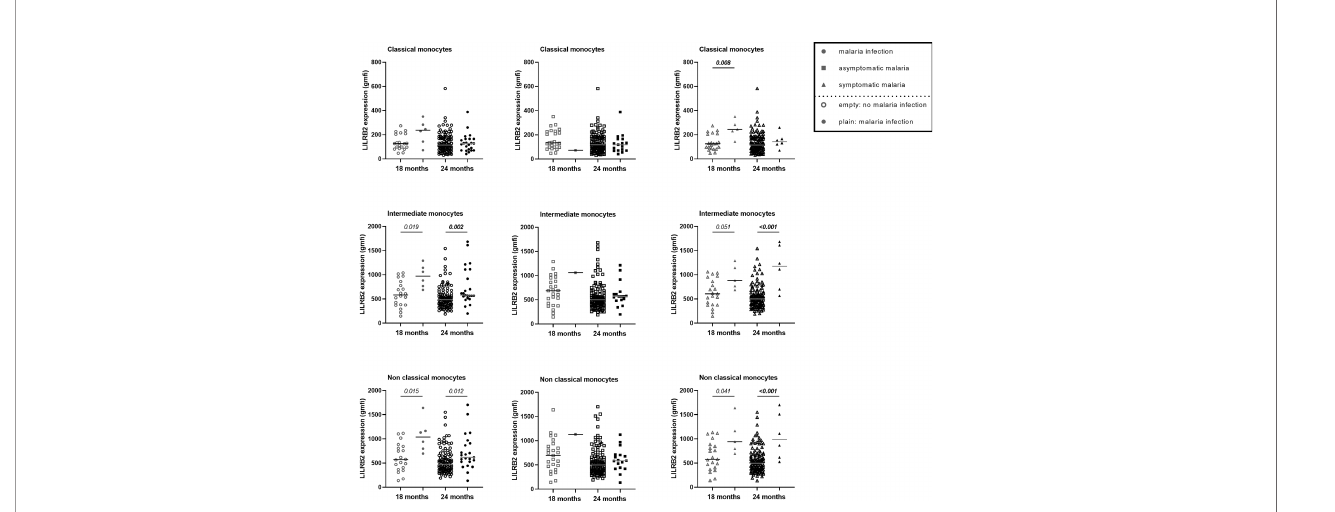
FIGURE 4 | Higher expression of LILRB2 on intermediate and non-classical monocytes at 18 and 24 months during active malaria. The expression of LILRB2 on immune cells was measured with the geometric mean of fl uorescence intensity (gm fi ) between infected and not-infected infants at 18 or 24 months of age. Respectively 16 and 25 Pf infections were reported at 18 and 24 months among which 10 and 6 were symptomatic Pf infections. Total, asymptomatic or symptomatic malaria infections were represented with plain circle, square and triangle respectively. No infection at the visit was represented with empty symbols. The horizontal dark line in the beeswarm plot represents the median value. The number of infants with total, asymptomatic or symptomatic malaria infections varies between 1 and 23 for all monocyte subtypes. A linear regression (univariate analysis) was performed to compare the expression between the two groups of infants. P values are indicated in italic. In bold are the associations still signi fi cant after Bonferroni correction.